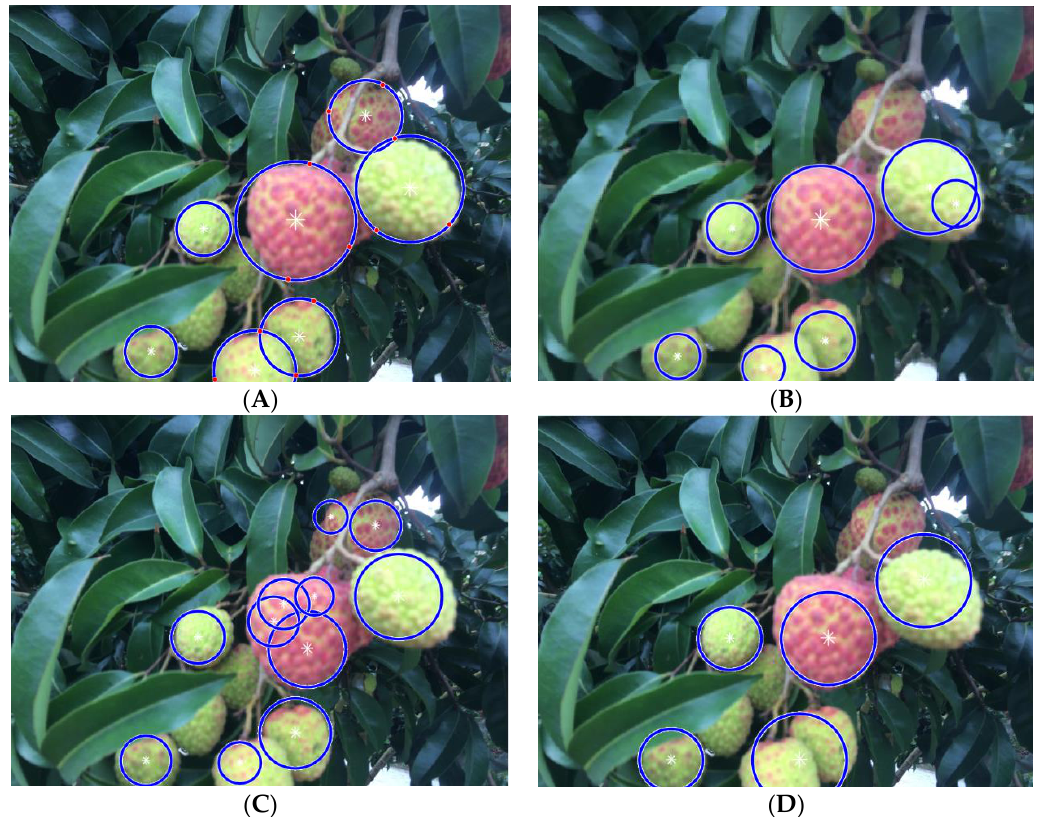
Figure 11. Results of lychee fruit cluster detection performance under well-illuminated conditions without using the local binary pattern based support vector machine (LBP-SVM) classifier. ( A ) Results of the proposed Method A. ( B ) Results of Method B. ( C ) Results of Method C. ( D ) Results of Method D.